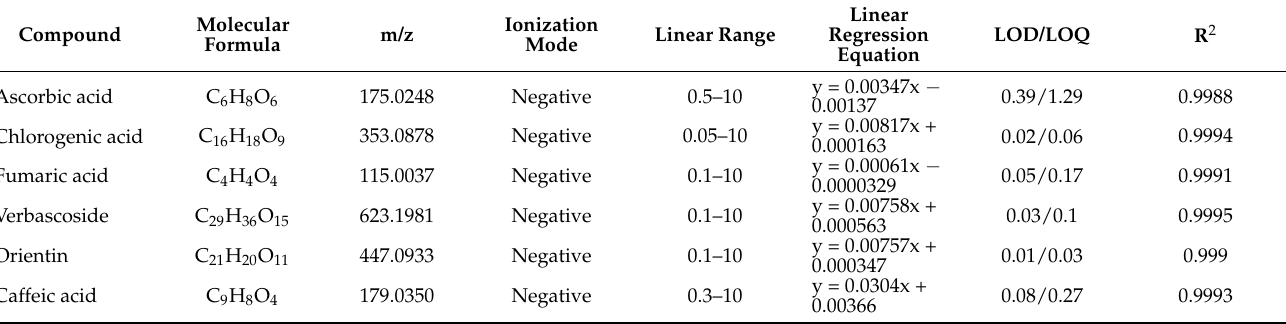
Table 7. Validation and uncertainty parameters for phenolic